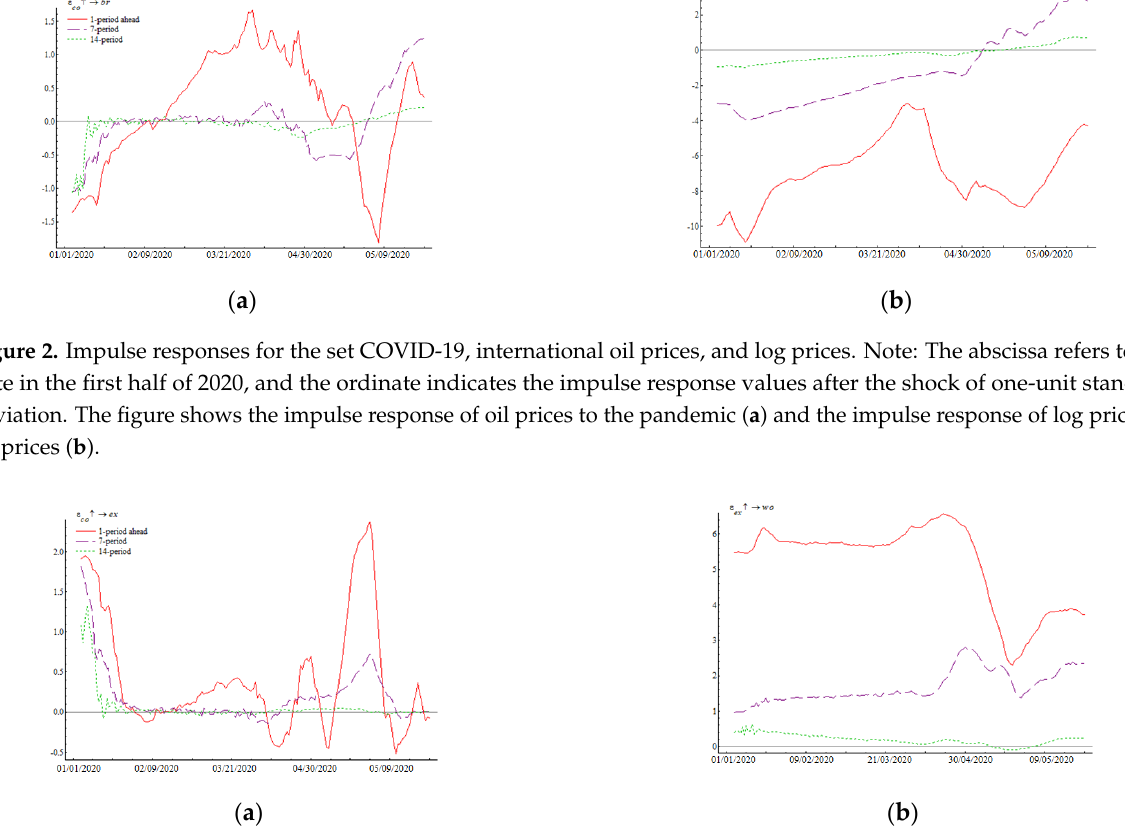
Figure 3. Impulse responses for the set COVID-19, exchange rate, and log prices. Note: The abscissa refers to the date in the first half of 2020, and the ordinate indicates the impulse response values after the shock of one-unit standard deviation. The figure shows the impulse response of exchange rate to the pandemic ( a ) and the impulse response of log prices to exchange rate ( b ).